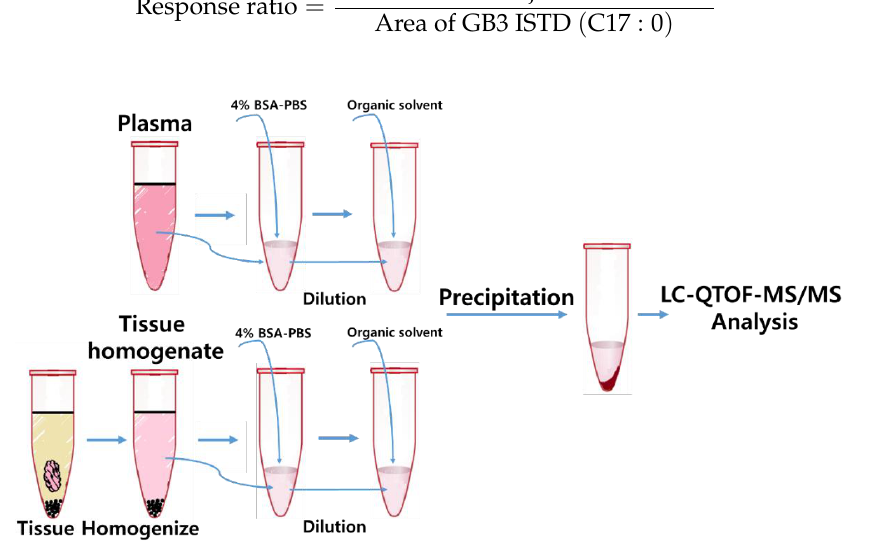
Figure 2. Sample preparation procedure. Table 1. Mass spectrometry conditions for six Globotriaosylceramide (GB3) isoforms.